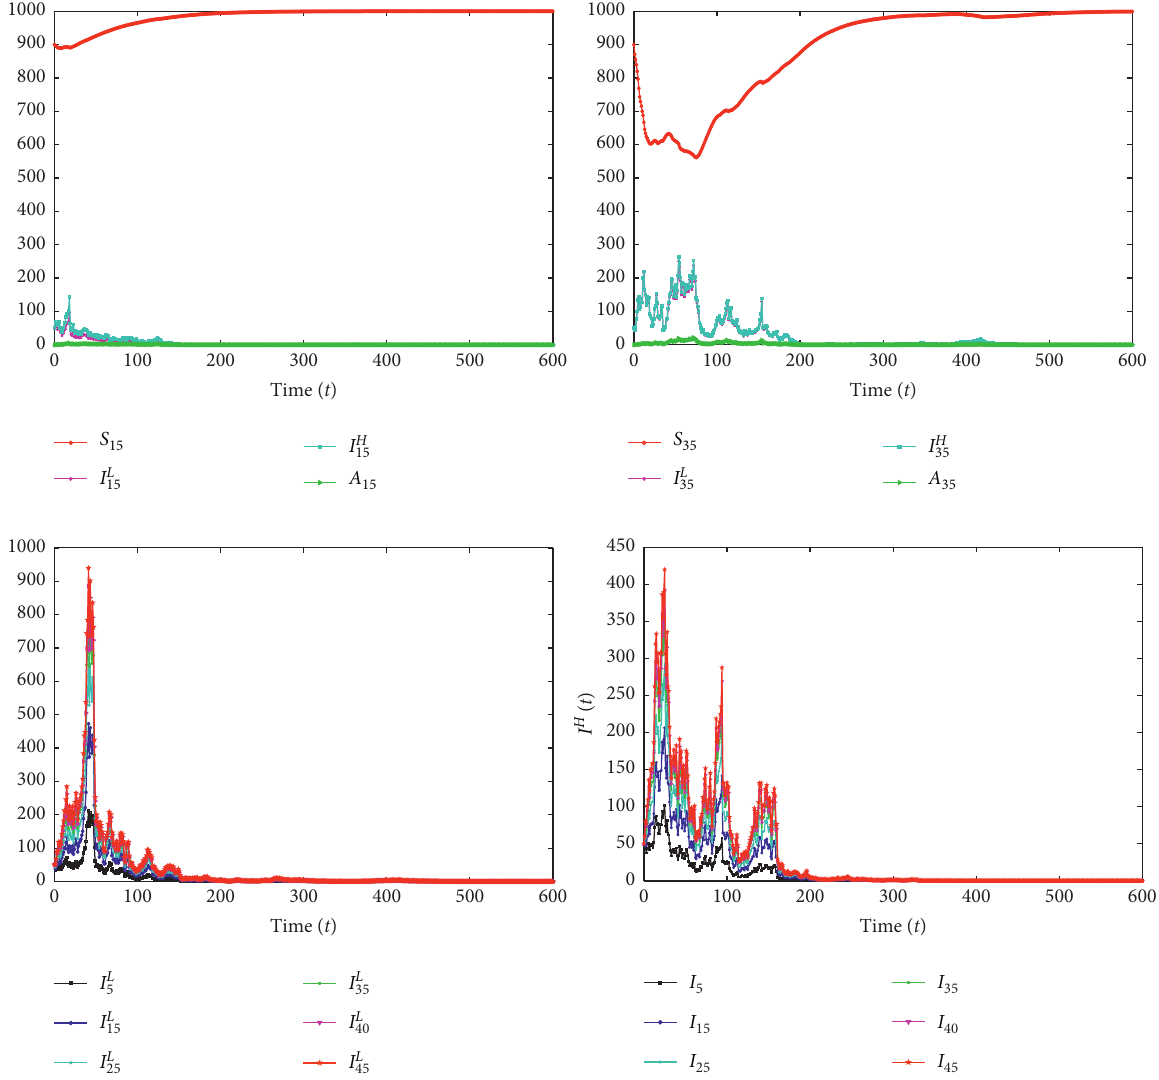
Figure 6: The time series and orbits of system (7) with R > 1 and stochastic control. The top two pictures are the sample paths of 0 ( t ) ,I L ( t ) ,I H ( t ) ,A ( t ) and S ( t ) ,I L ( t ) ,I H ( t ) ,A ( t ) . The last two pictures are sample paths of I L ( t ) and I H ( t ) with degree S 15 15 35 35 15 15 35 35 k � 5 , 15 , 25 , 35 , 40 , 45. The malware will be extinct in the